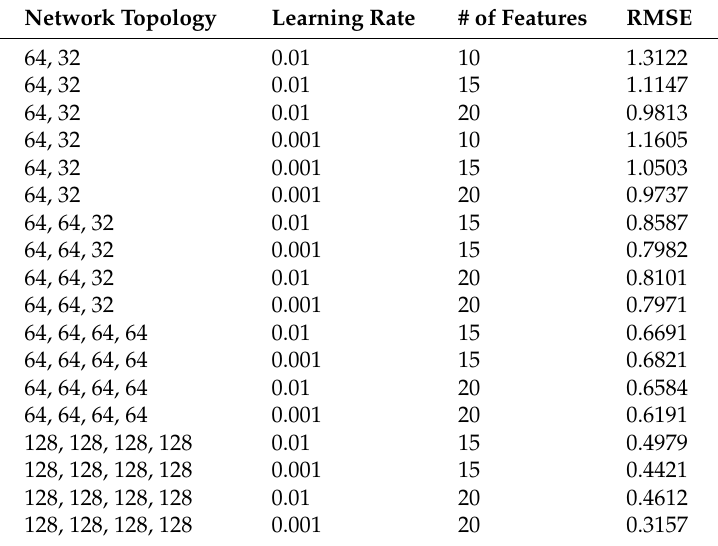
Table 2. Detailed regression results of the Deep Feed Forward Neural Network model. Each tested topology is characterized by a specific configuration of layers and units per layer (see the first table